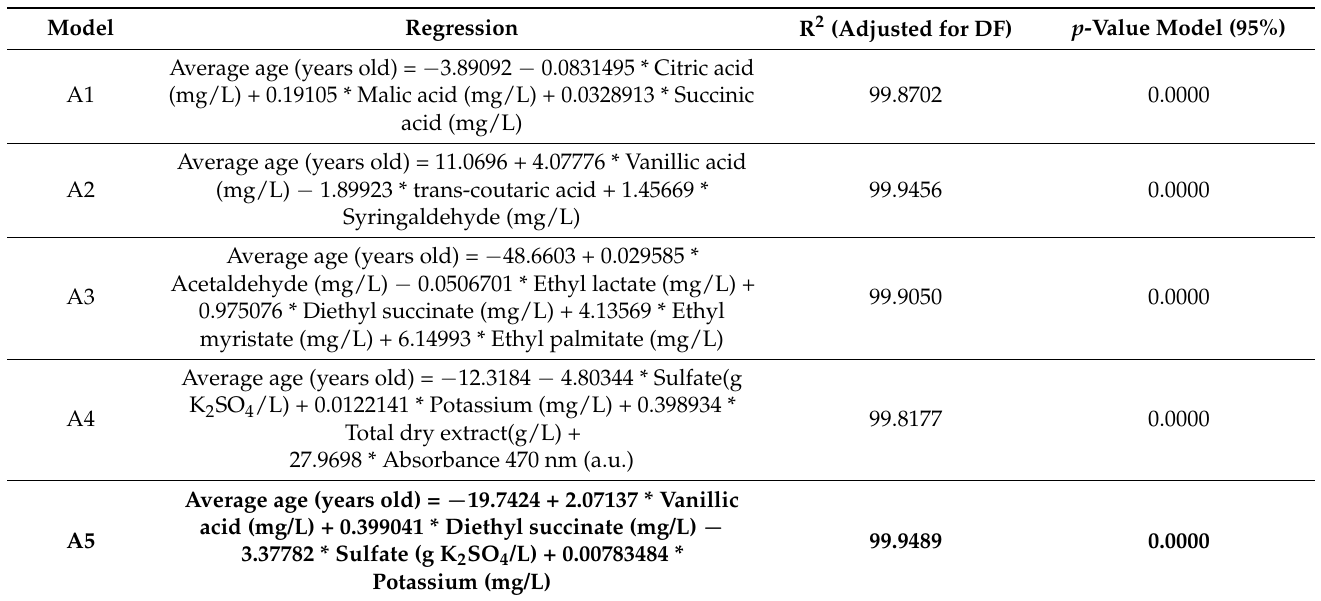
Table 12. Regression models (MLR) to estimate the aging of Amontillado wines. A1: organic acids and glycerol model; A2: polyphenols model; A3: volatile compounds model; A4: “other variables” model; A5: overall model.